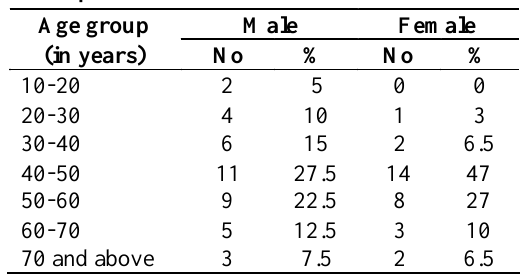
Table I : Age and sex wise distribution of tuberculo- sis suspects